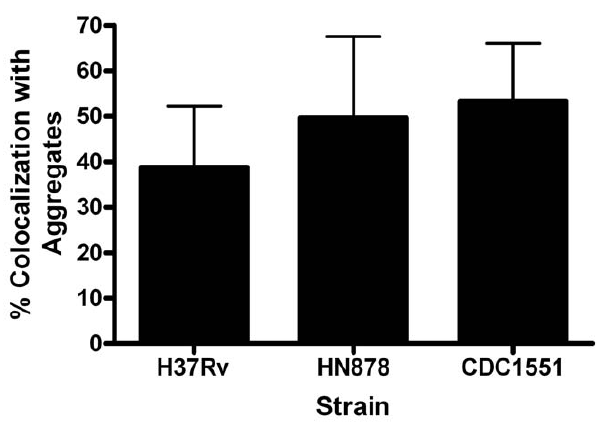
Figure 8. CDC1551, HN878 and H37Rv bacilli colocalize with LR aggregates. A549 cells were infected with live Mtb strains CDC1551, HN878 and H37Rv, and colocalization of fluorescent bacteria with LR aggregates was quantified as described. No statistical difference was noted for LR colocalization between strains at 24 hpi. Infections were performed in triplicate and repeated three times. Analysis was performed on 15 fields per coverslip using ImageJ JACoP plugin. Images were captured at 63x magnification.